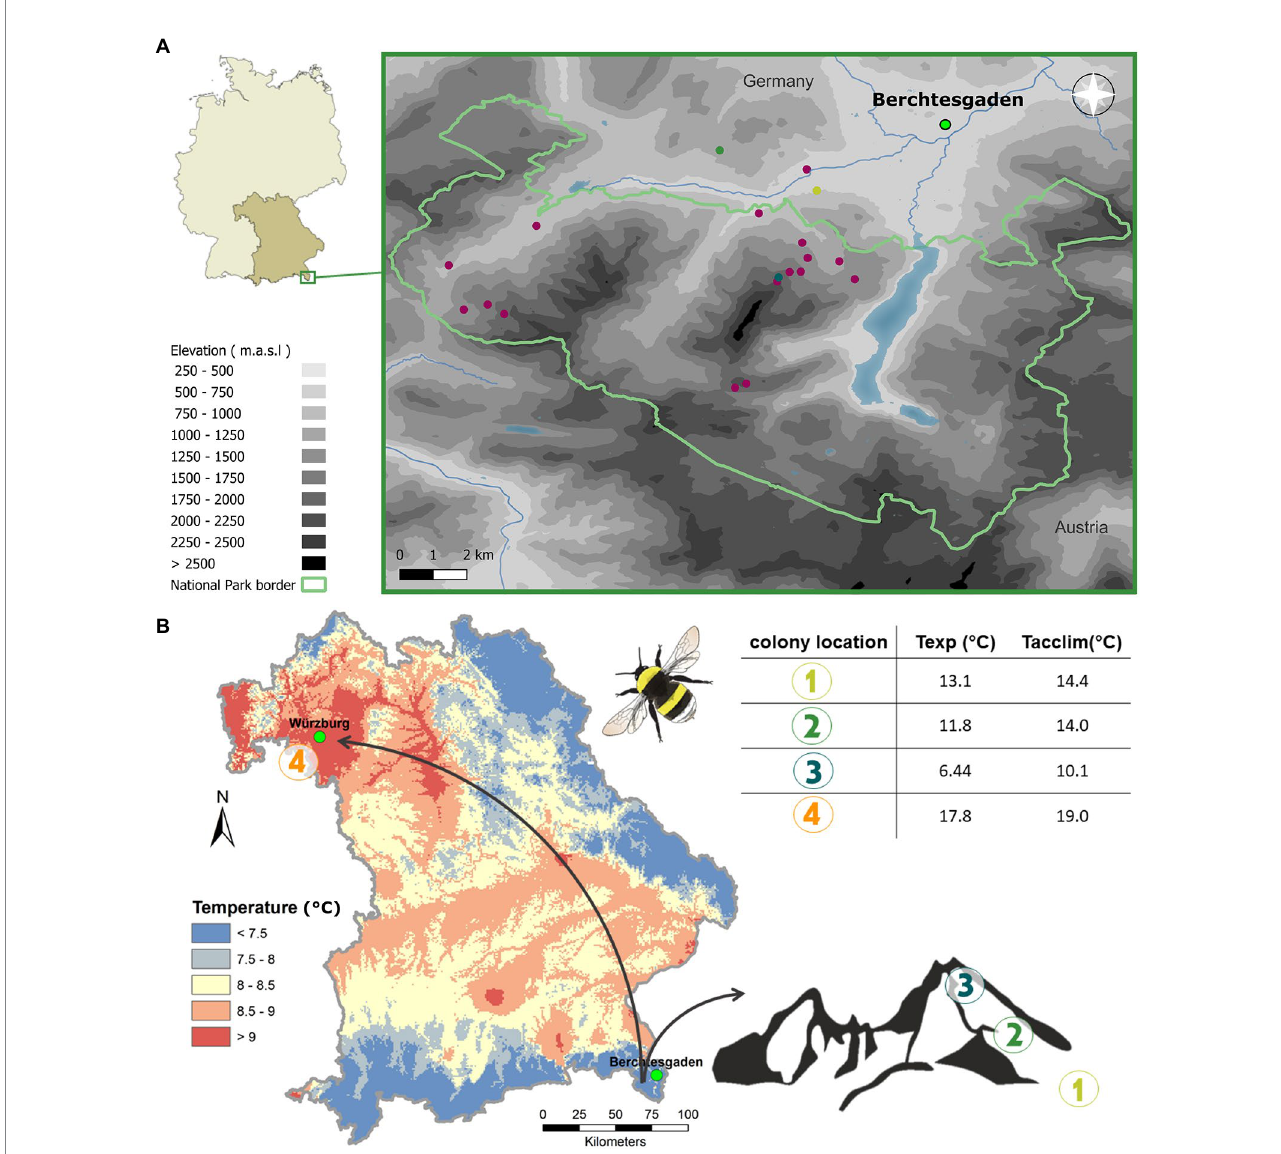
FIGURE 1 Study design. (A) Study region and sites in Berchtesgaden (Bavaria, Germany). Elevation level is indicated in shades (at 250 m intervals), with darker shades signaling increasing elevation. The National Park border is represented with a green line. Points show study sites. Red sites were used for bumble bee collection in approach 1 and 2, while yellow, green, and blue sites represent sites which were additionally used for the translocation approach (approach 3). (B) Schematic description of the colony translocation (approach 3). Queens collected from the valleys in spring in our study region were reared in the lab and then settled with their first offspring in nest boxes. Numbers indicate new colony locations. In the cold and wet region of origin: mountain foothills (1), mountain mid (2), mountain high (3) (see also Panel A, where mountain sites are shown in respective colors), and in the warm and dry region (4), where the mountain sites are shown according to their color in Panel A . The table lists the temperature regimes to which the colonies were exposed either over the course of the translocation (=Texp) or within the week before sampling along the elevational gradient (=Tacclim). Color code in the map refers to multi annual means of air temperature conditions. Maps were produced in QGIS. Data was obtained from https://www.lfu.bayern.de/umweltdaten, https:// search.earthdata.nasa.gov, and